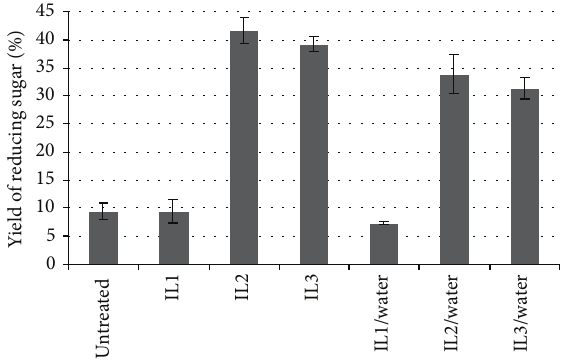
Figure 5: Yields of reducing sugar after enzymatic hydrolysis. IL1: [BMIM]Cl/DMSO, IL2: [HMIM]Cl, and IL3: [HSO 3